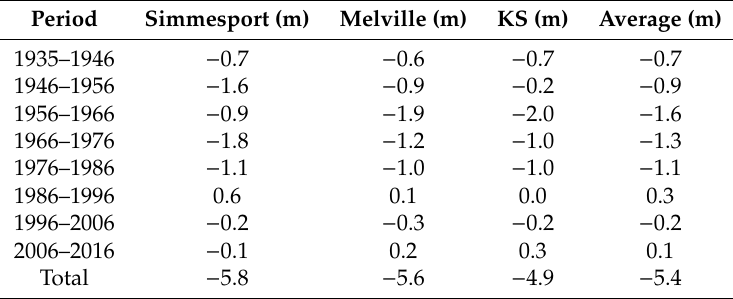
Table 1. River stage changes at Simmesport, Melville, and Krotz Springs (KS) along the uppermost Atchafalaya River during 1935–2016 at discharge 8000 ± 100 m 3 s − 1 .